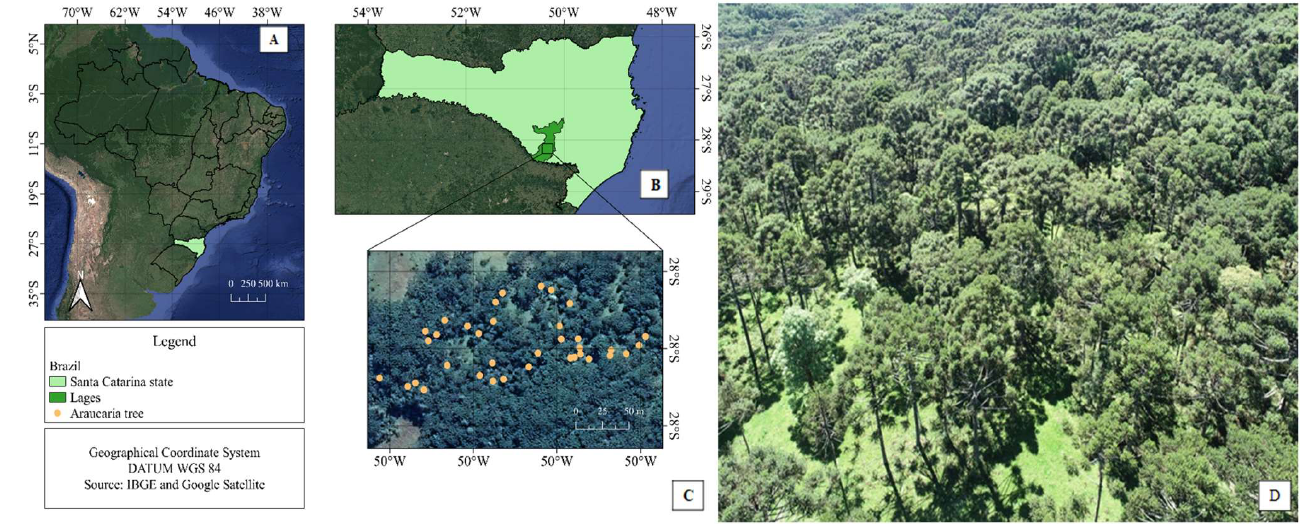
Figure 1. The geography of the study area: ( A ) study area location, ( B ) study area boundary, ( C ) shows each tree, location of the study area, and ( D ) aerial view of the study remnant, demonstrating the dominance of the A. angustifolia species and the formation of a regular forest.